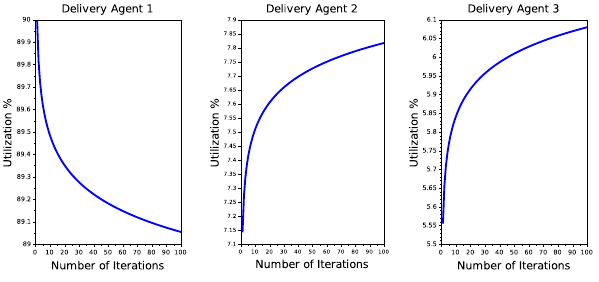
Figure 5. Convergence Analysis with Primal Decomposi-